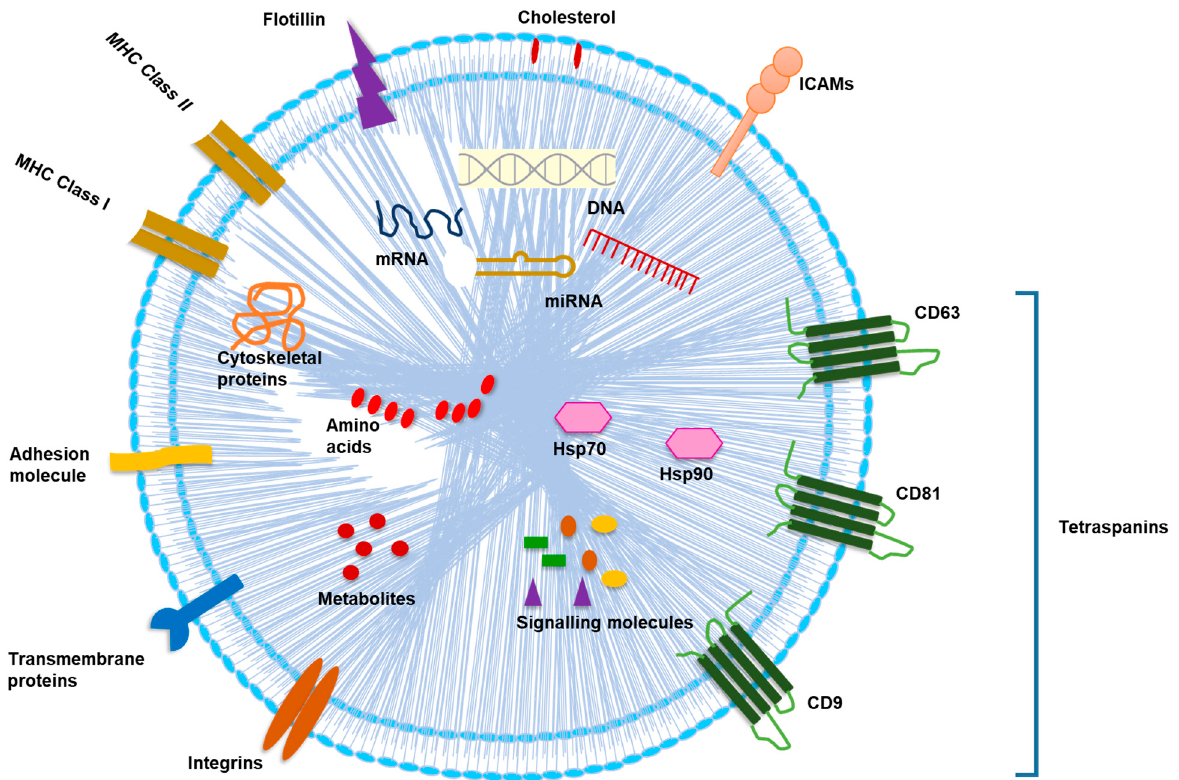
Figure 1. Structure of exosome with membrane proteins and cargoes. Exosomes consist of many constituents of a cell including DNA, RNAs, amino acids, proteins, metabolites, enzymes, lipids (cholesterol) and Hsps along with several cytosolic and cell-surface signaling proteins which are involved in intercellular communications. Exosomal membrane is rich in transmembrane proteins (tetraspanins such as CD81, CD63 and CD9), flotillin, ICAMs, integrins and adhesion molecules. They consist of immune components including MHC class I and class II molecules. Abbreviations: CD, cluster of differentiation; DNA, deoxyribonucleic acids; Hsps, heat shock proteins; ICAMs, intercellular adhesion molecules; MHC, major histocompatibility complex; mRNA, messenger RNA; miRNA, microRNA.